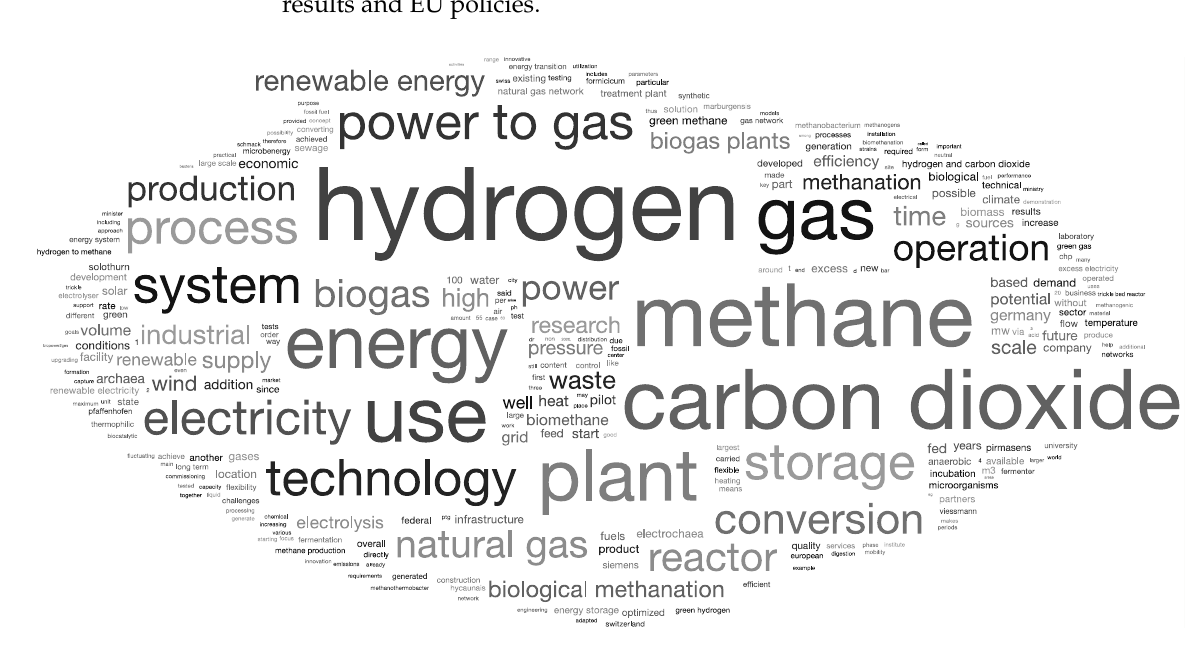
Figure 3. Word cloud from biomethanation project descriptions.